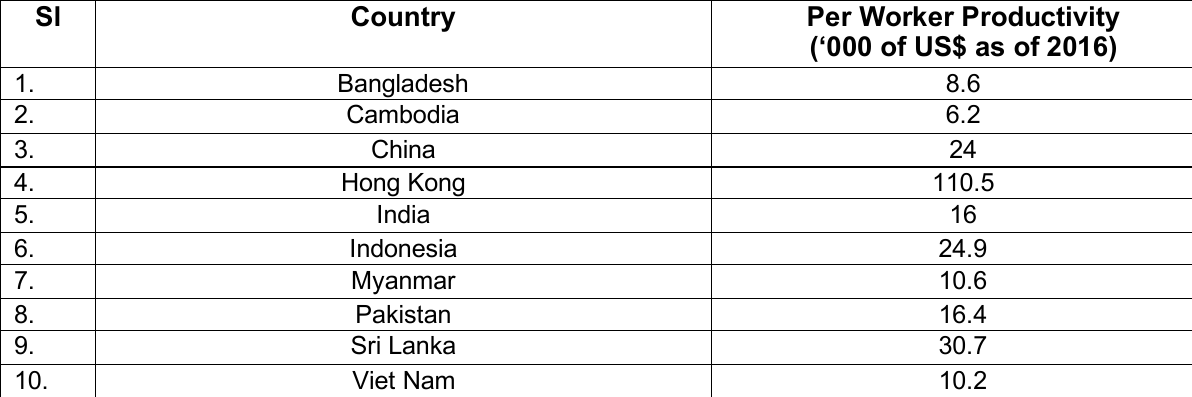
Table 2: Per Worker Productivity of Bangladesh and Its’ Apparel Exporting Competing Countries Sl Country Per Worker Productivity (‘000 of US$ as of 2016)